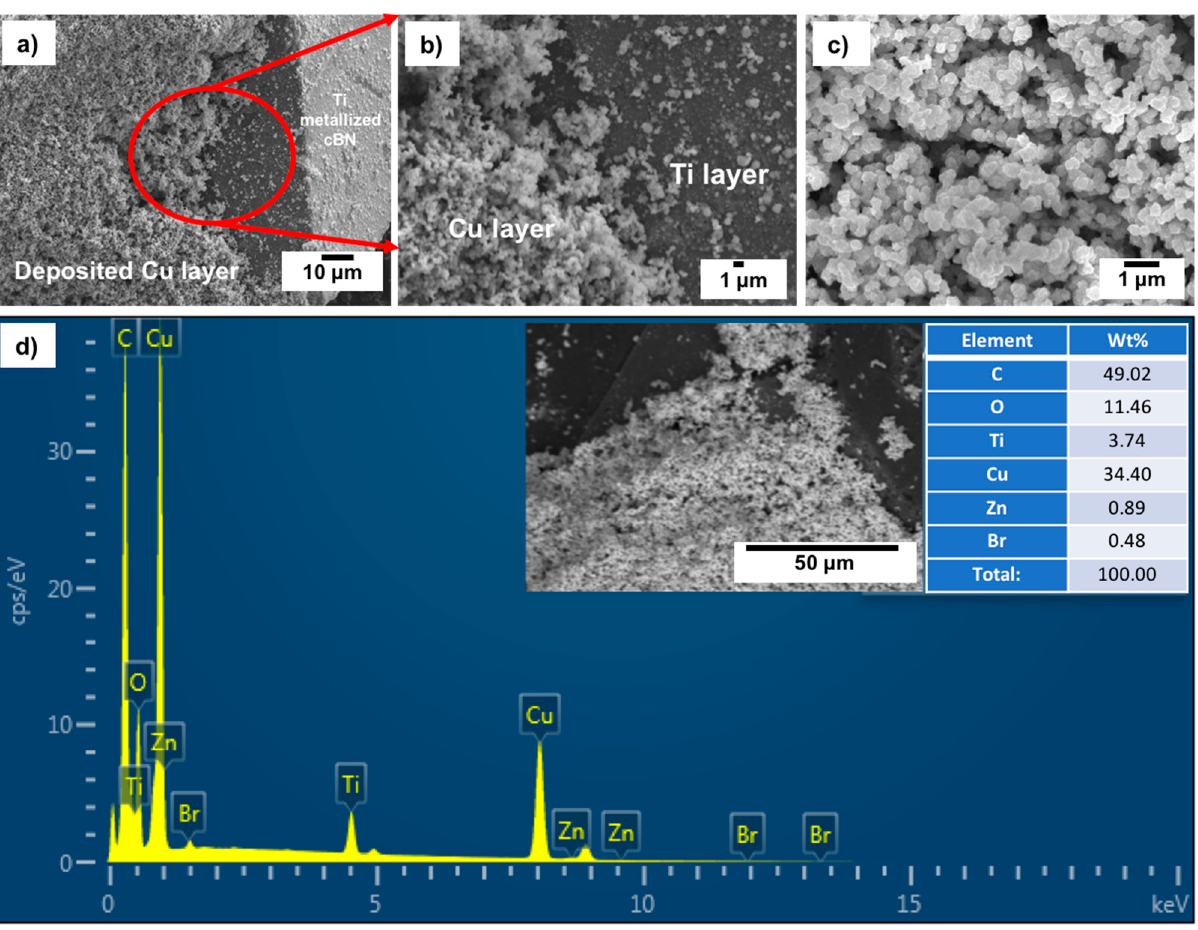
Figure 9. ( a – c ) FESEM images with different magnification and ( d ) EDAX compositional spot analysis of the Ti-metallized cBN/Cu composite particles (C peak is the background).